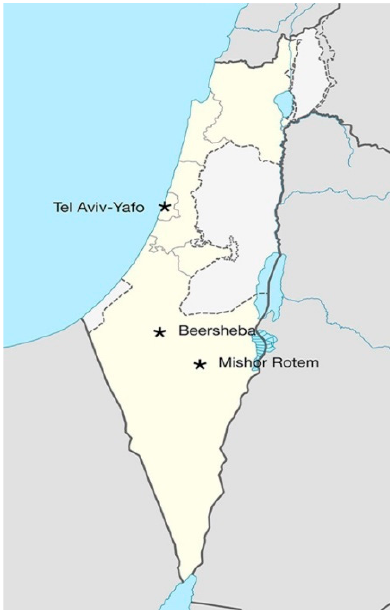
Figure 1. The Mishor-Rotem region–the location of the area under study.